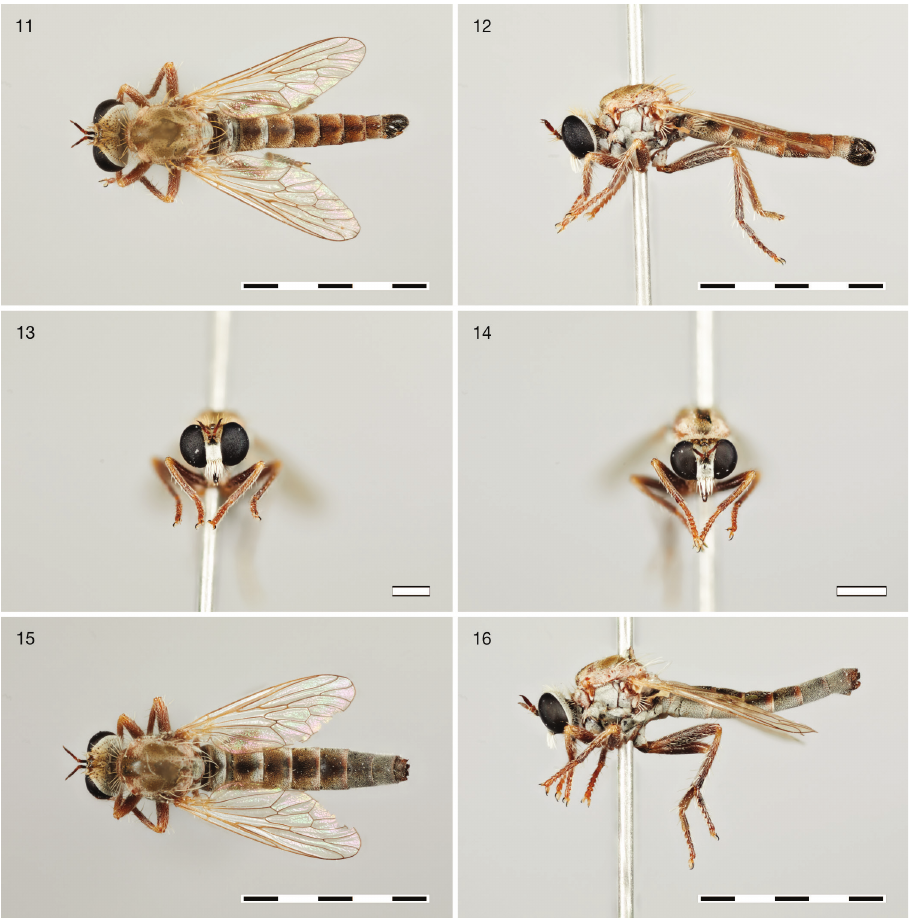
Figures 11–16. Microphontes gaiophanes sp. n.: 11 ♂ Paratype (USNMENT01384092) dorsal (Mor- phbank #861767) 12 same, lateral (#861769) 13 same, head anterior (#861771) 14 ♀ Paratype (USN- MENT01384008) head anterior (#861474) 15 same, dorsal (#861470) 16 same, lateral (#861472). Scale bars : 5 mm ( 11–12, 15–16 ), 1 mm ( 13–14 1 antero-dorsal distally, 1–2 dorsal distally; mes tibia light brown to brown, short white setose, yellowish macrosetose: 4 in 2 dorsal rows, 3 in 1 antero-ventral row, 3 in 1 postero-ventral row, distal tip with 5 long yellowish macrosetae; met coxa brown, grey pubescent, white setose and macrosetose, anteriorly without any protuberance; met trochanter yellowish macrosetose, cylindrical, medially without any protuberance; met femur brown, short white setose, yellowish macrosetose: 3–4 in 1 anterior row, 1 proximal ventrally, 2 distal dorsally, 3 apical dorsally; met tibia brown, straight, short white setose, yellowish macrosetose: 4 in 1 anterior row, 3 in 1 antero-ventral row, 4 in 1 dorsal row, distal tip with 6 long yellowish macrosetae; proximal pro, mes and met tarsomeres longer than following 2 tarsomeres combined, proximal met tarsomere